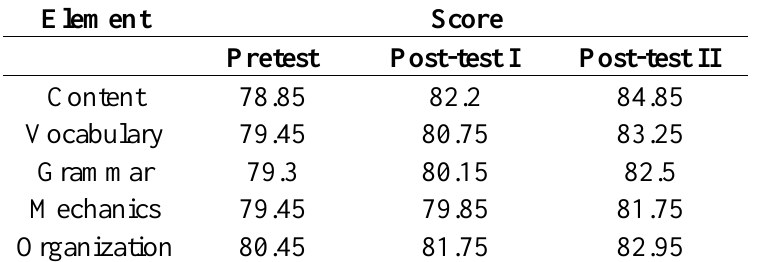
Table 4.5 Students’ Scores of Pretest, Post-test of Cycle 1 and Post-Test of Cycle